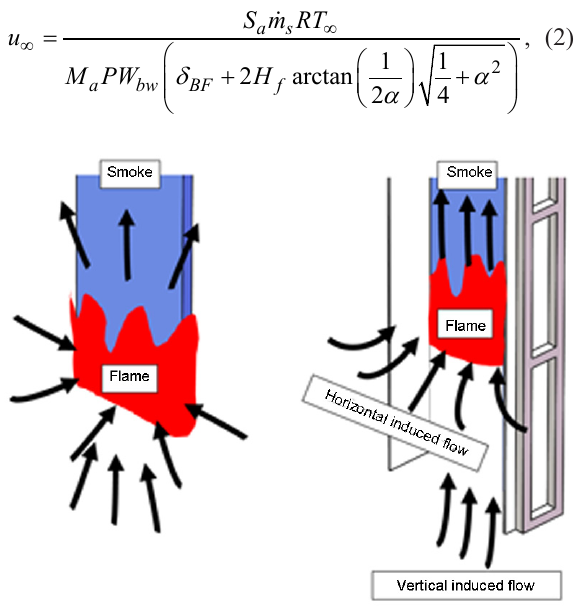
Fig. 11. Illustration of air entrainment mechanism of downward flame spread with (right) and without (left)